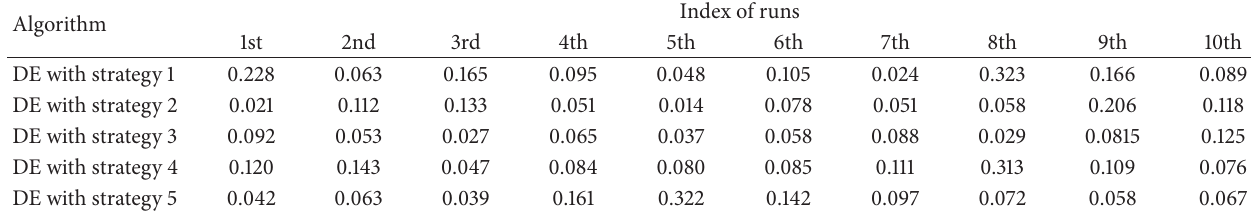
Table 3: PSLLs in 10